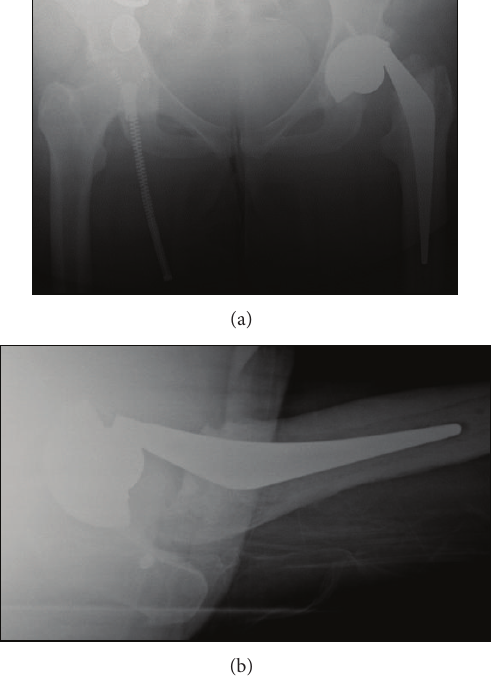
Figure 2: (a) AP and (b) lateral radiographs of the dissociated